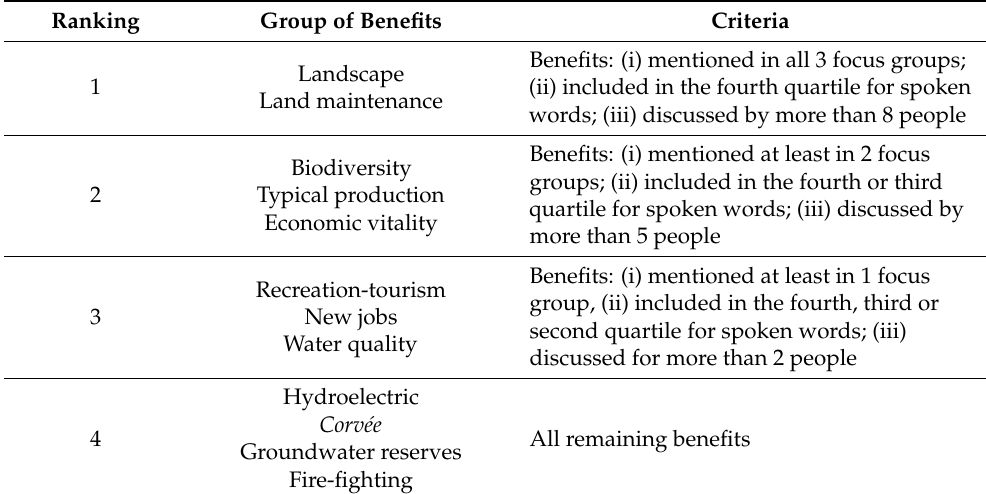
Table 2. Group of benefits ranked based on the selected criteria for question